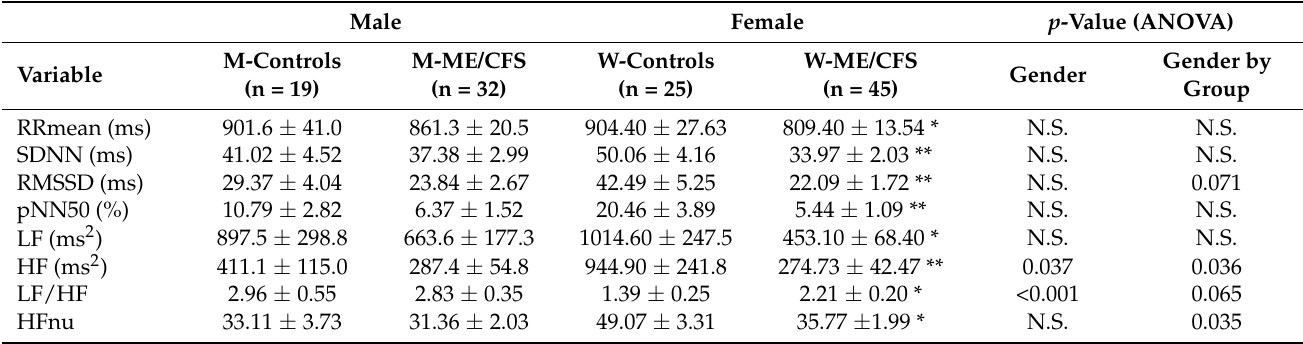
Values are shown as mean ± SEM. * Differences with controls for the same gender ( p < 0.05). ** Differences with controls for the same gender ( p < 0.001). “Gender”: Gender differences for all samples. “Gender by Group”: Gender differences depending on the group